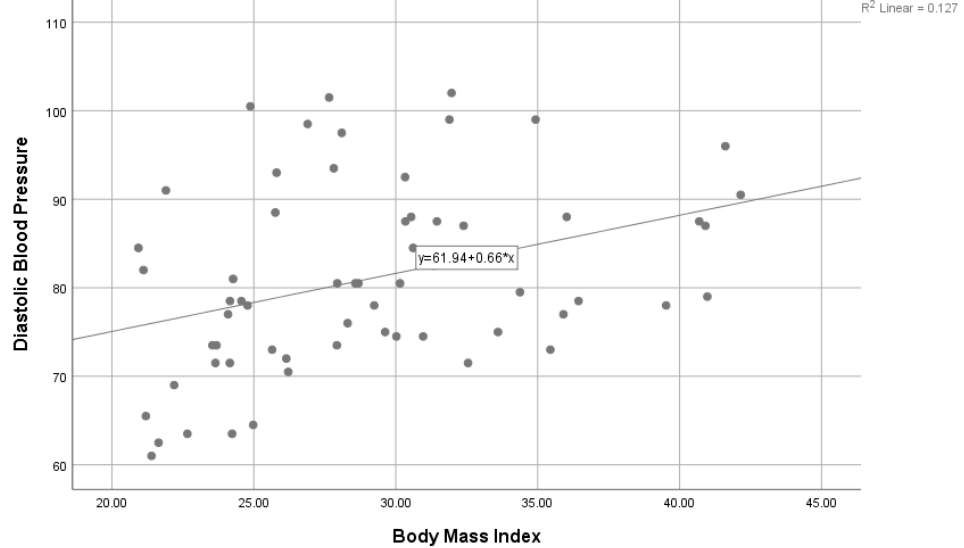
Figure 2. Correlation between DBP (mm/Hg) and BMI (kg/m 2 ).